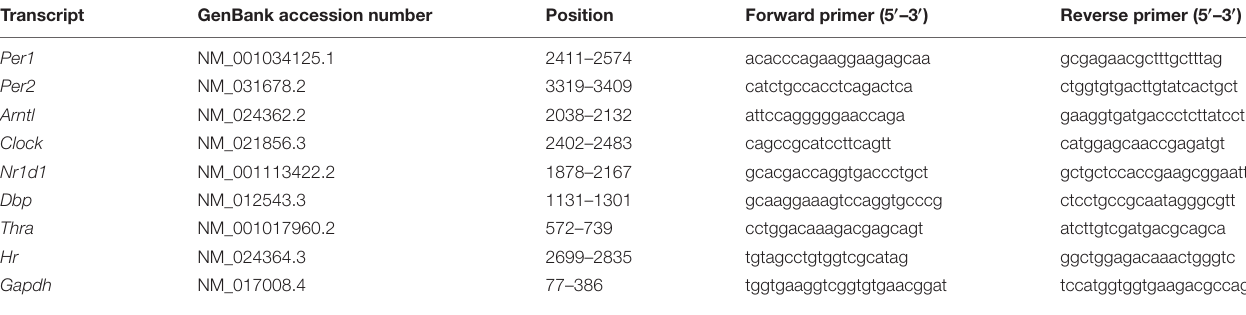
TABLE 1 | Sequences of primers used for